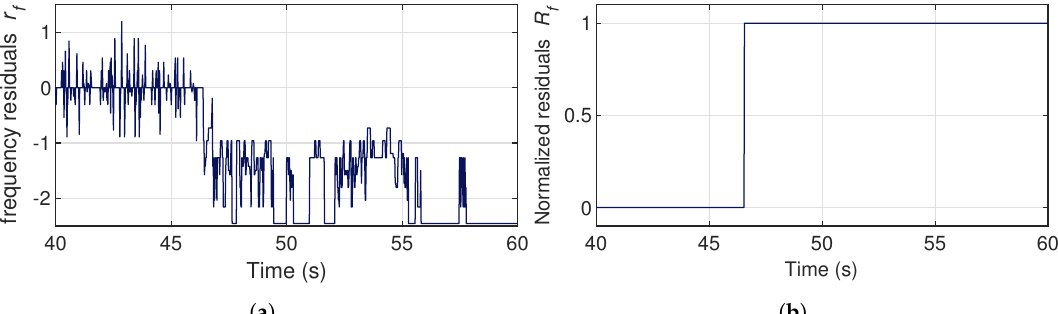
Figure 15. Profile of the frequency residuals during faulty operation. Frequency is blocked at the maximum value around t = 46s at which time an alarm is generated. ( a ) Raw residuals r f . ( b ) Averaged residuals R f